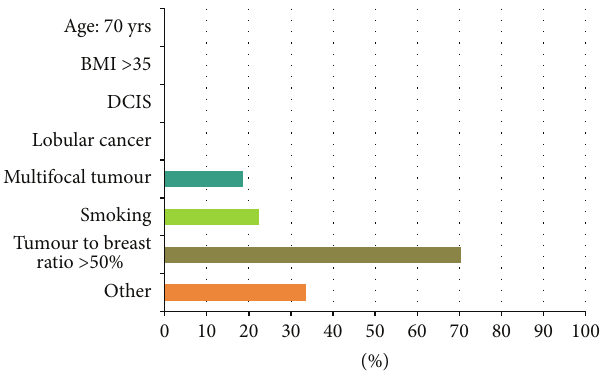
Figure 3: What would you consider as absolute contraindications to performing the procedure? 20% of respondents would always offer mastectomy for involved margins and 3% would always offer